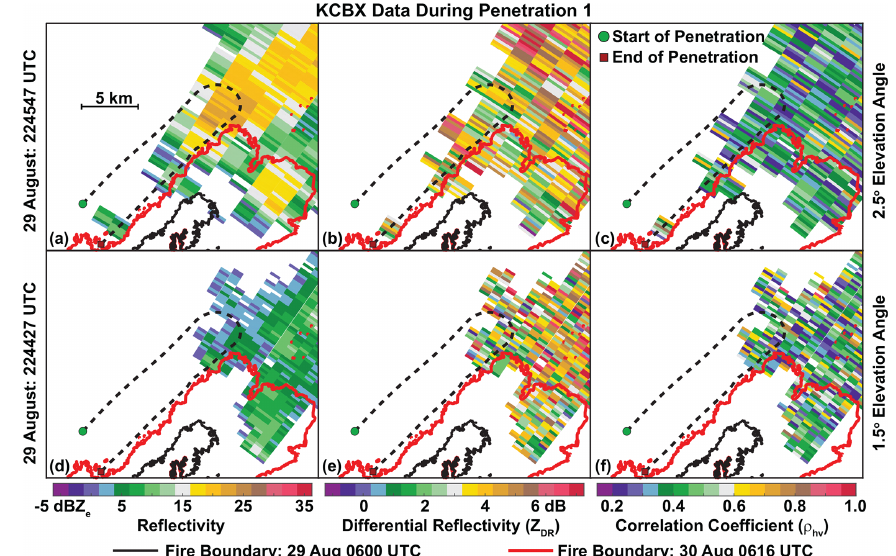
Figure 2. KCBX data approximately coincident with the execution of penetration 1. Left column (a, d) shows reflectivity, middle column (b, e) shows differential reflectivity ( Z DR ), and right column (c, f) shows correlation coefficient ( ρ hv ). Color scales at bottom of each column indicate plotted values. Top row (a–c) is for data at 22:45:47UTC 29 August 2016 (2.5 ◦ elevation angle), and bottom row (d–f) is for data at 22:44:27UTC 29 August 2016 (1.5 ◦ elevation angle). Perimeters of the Pioneer Fire at 06:00UTC 29 August 2016 and 06:16UTC 30 August 2016 are indicated with black and red lines, respectively. Dashed black lines show the location of penetration 1, with green circles and red squares indicating the start and end of the penetration, respectively.